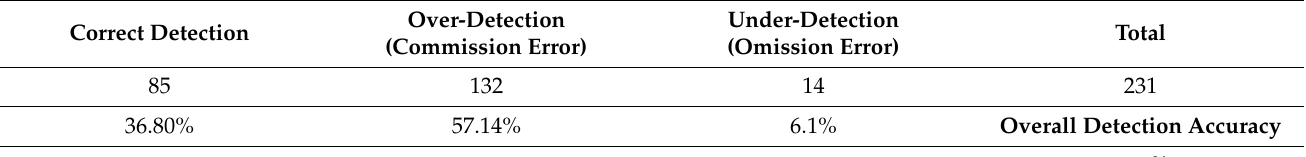
Table 6. Individual tree detection accuracy for the unmanned aerial system (UAS) imagery segmentation. Correct